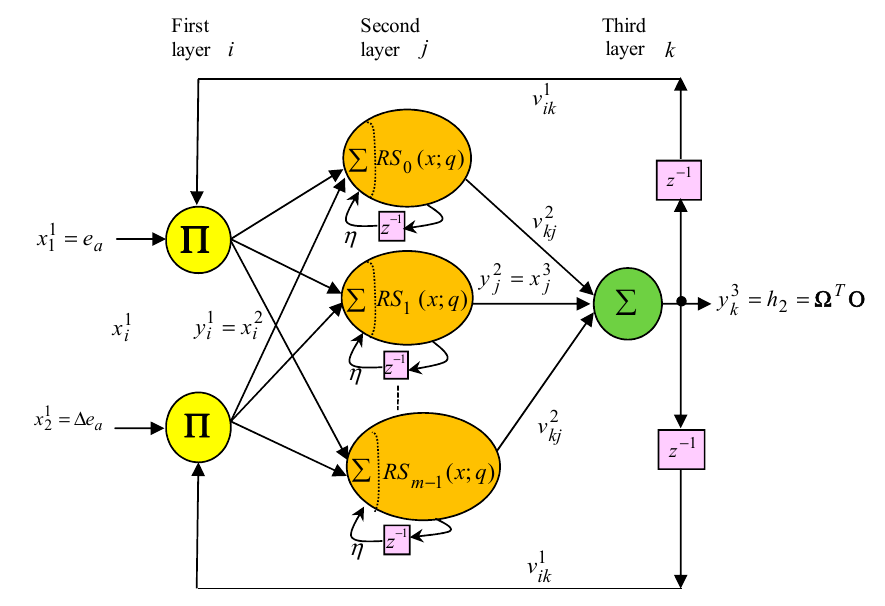
Figure 4. Constitution of the MRRSPNN.